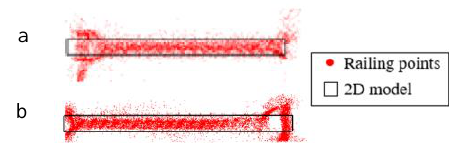
Figure 10. Fitting 2D primitive models of the railing elements: a: bridge 1; and b: bridge 2.